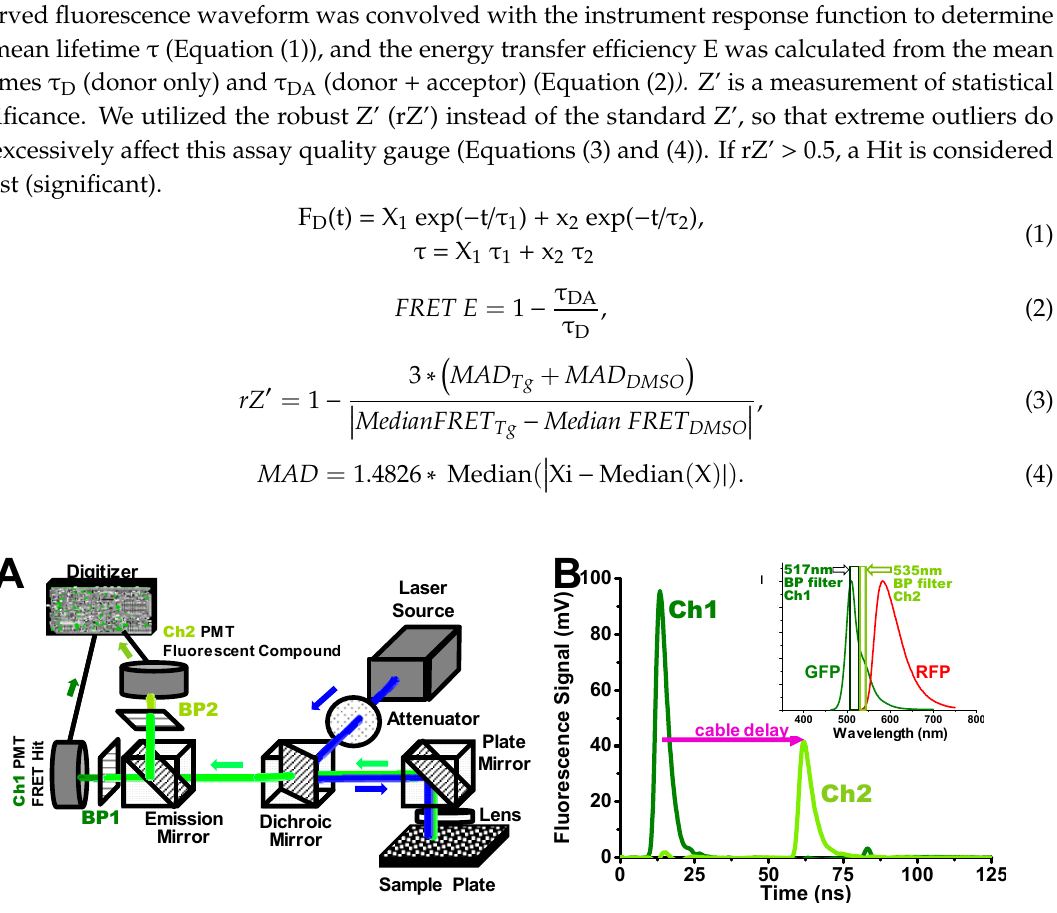
Figure 1. Dual-channel high-throughput fluorescence lifetime plate reader (FLT-PR), manufactured by Fluorescence Innovations Inc. and provided by Photonic Pharma, LLC. ( A ) This diagram is an overview of the instrument capable of detecting high-precision nanosecond-resolved FLT waveforms acquired at speeds of up to 1536 wells (one plate) in 2.5 min, which was originally based on single-channel detection [9]. Here a dichroic mirror splits the fluorescence signal into two, so it can be simultaneously detected by two separate photomultiplier tubes (PMT) at two wavelengths (channels). ( B ) The green and red fluorescent proteins (GFP) FLT signal at the peak of the GFP emission spectrum (inset), using a 517 ± 10 nm bandpass (BP) filter (Ch1). In the second channel (Ch2), detected simultaneously by a separate PMT, a 535 ± 7 nm BP filter (inset) is used to detect interference from fluorescent compounds (see text). The detection at Ch1 and Ch2 is simultaneous (from the same laser pulse), but the Ch2 signal is delayed by ~40 ns by a length of cable, to avoid electrical interference between the channels.